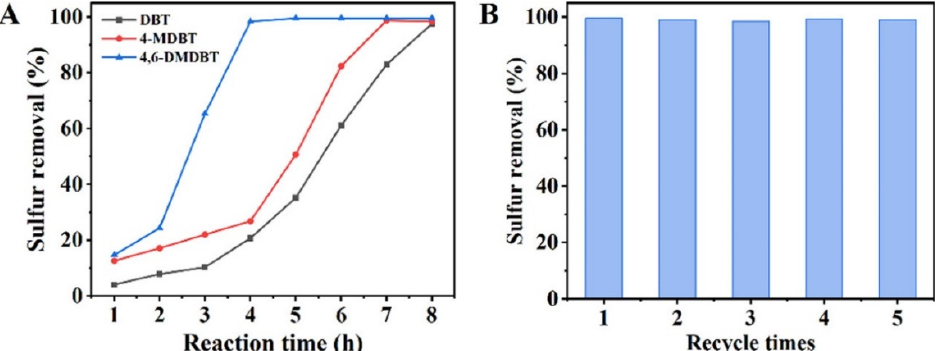
Figure 1. Proposed Catalytic Mechanism of Aerobic Oxidation of DBT Over CoNiMo Catalysts [67].